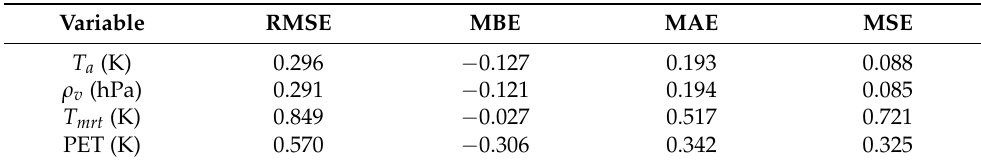
Table 4. Root mean square error (RMSE), mean bias error (MBE), mean absolute error (MAE), and mean squared error (MSE) for air temperature ( T a ) (K), mean radiant temperature ( T mrt ) (K), vapor pressure ( ρ v ) (hPa), and physiologically equivalent temperature (PET) (K) from a MoBiMet in an office relative to an adjacent Kestrel 5400 Heat Stress Tracker. Variable RMSE